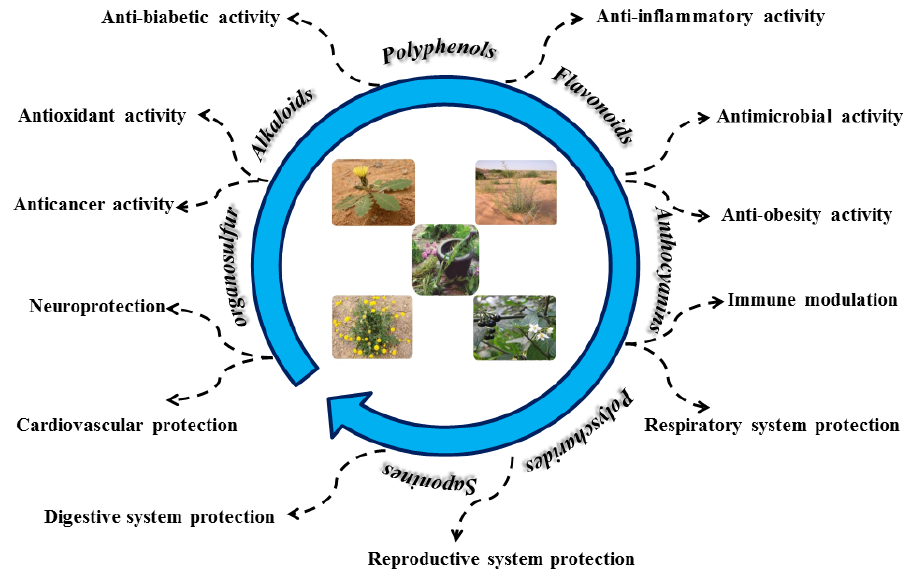
Figure 2. The most important biological activities of plant